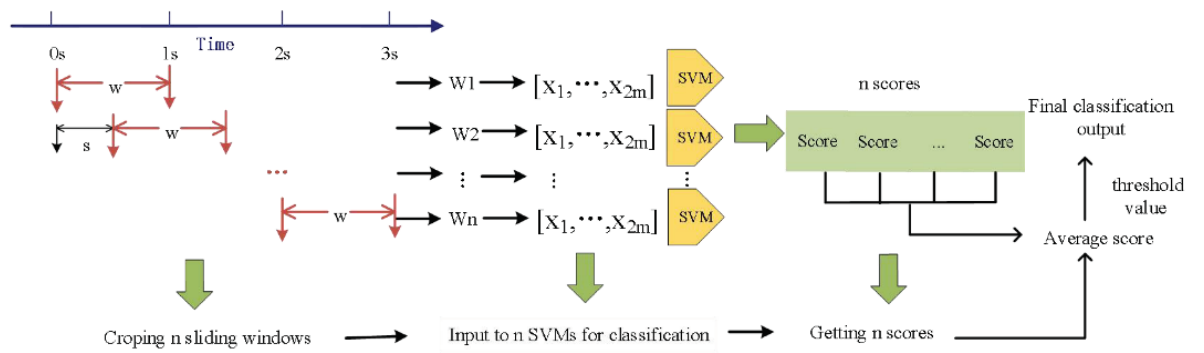
Figure 6. Schematic diagram of the AS decision algorithm.